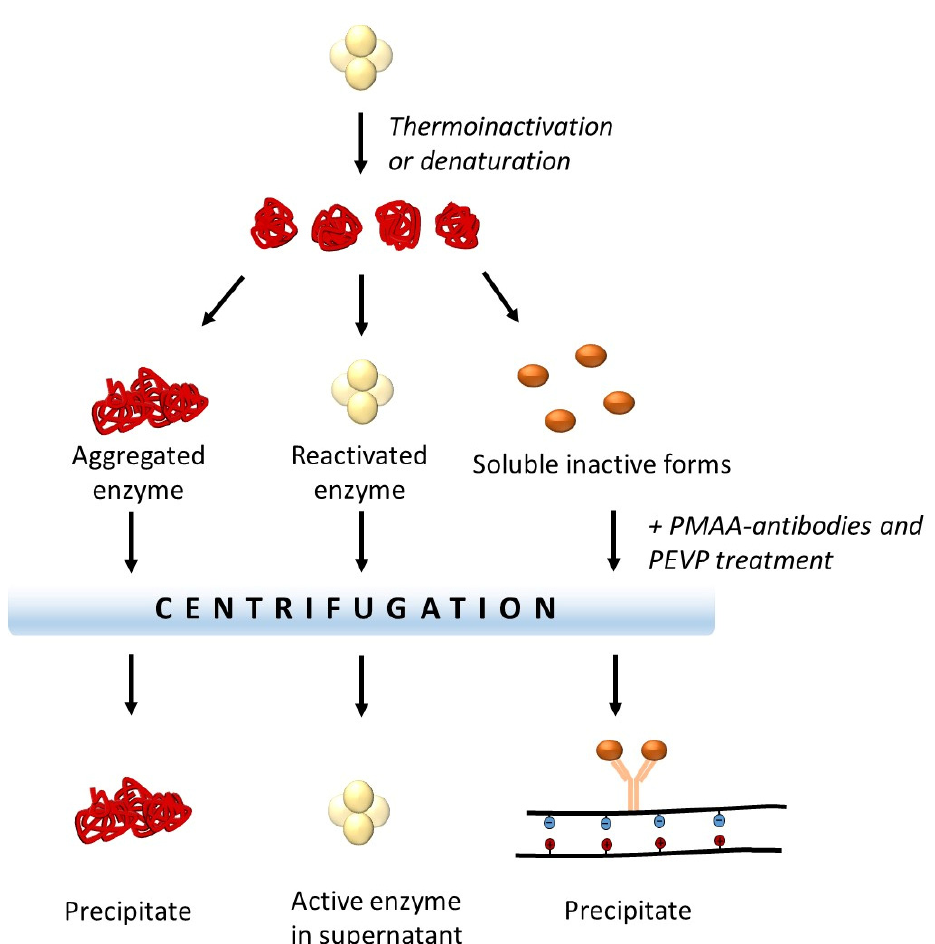
Figure 3. The use of polyelectrolytes with immobilized antibodies against non-native forms of the protein to increase the specific activity of enzymes (modified from the article [74]) PEVP—poly(4- vinyl-N-ethylpyridinium bromide), PMAA—poly(methacrylic acid).